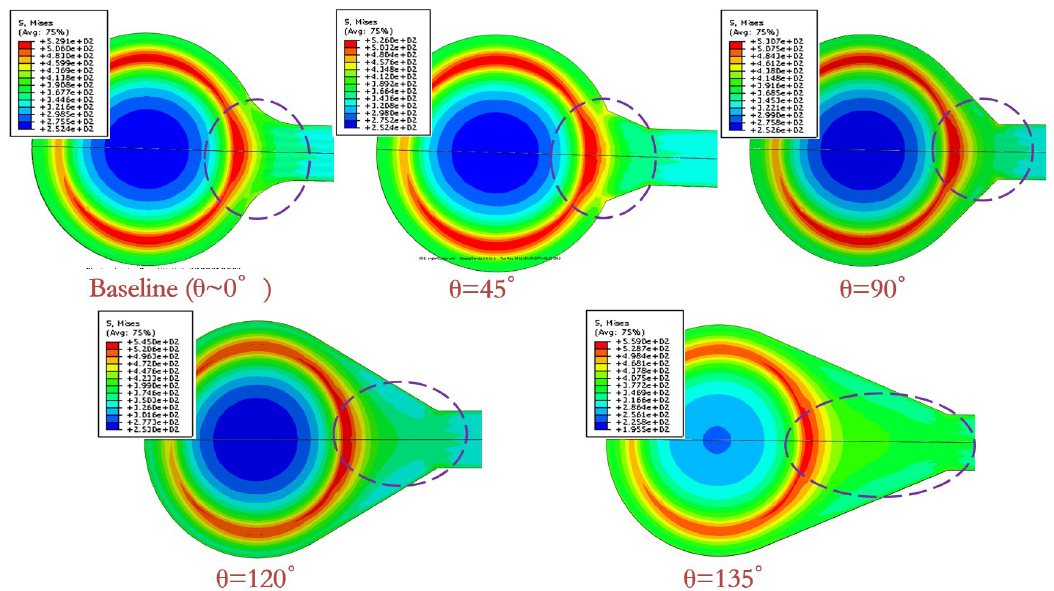
Figure 8. Stress distribution of pad in one TC cycle. Table 3. The max von Mises stress of different UBM design.